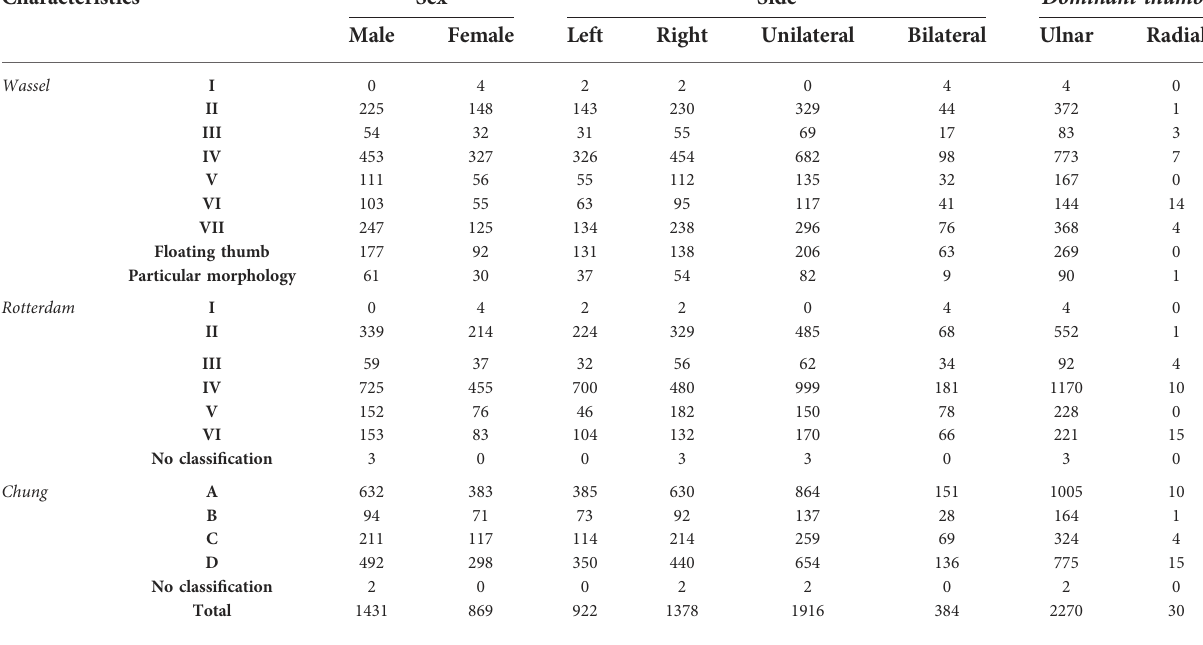
TABLE 1 Wassel-Flatt, Rotterdam and Chung subtypes according to demographic characteristics of patients. Characteristics